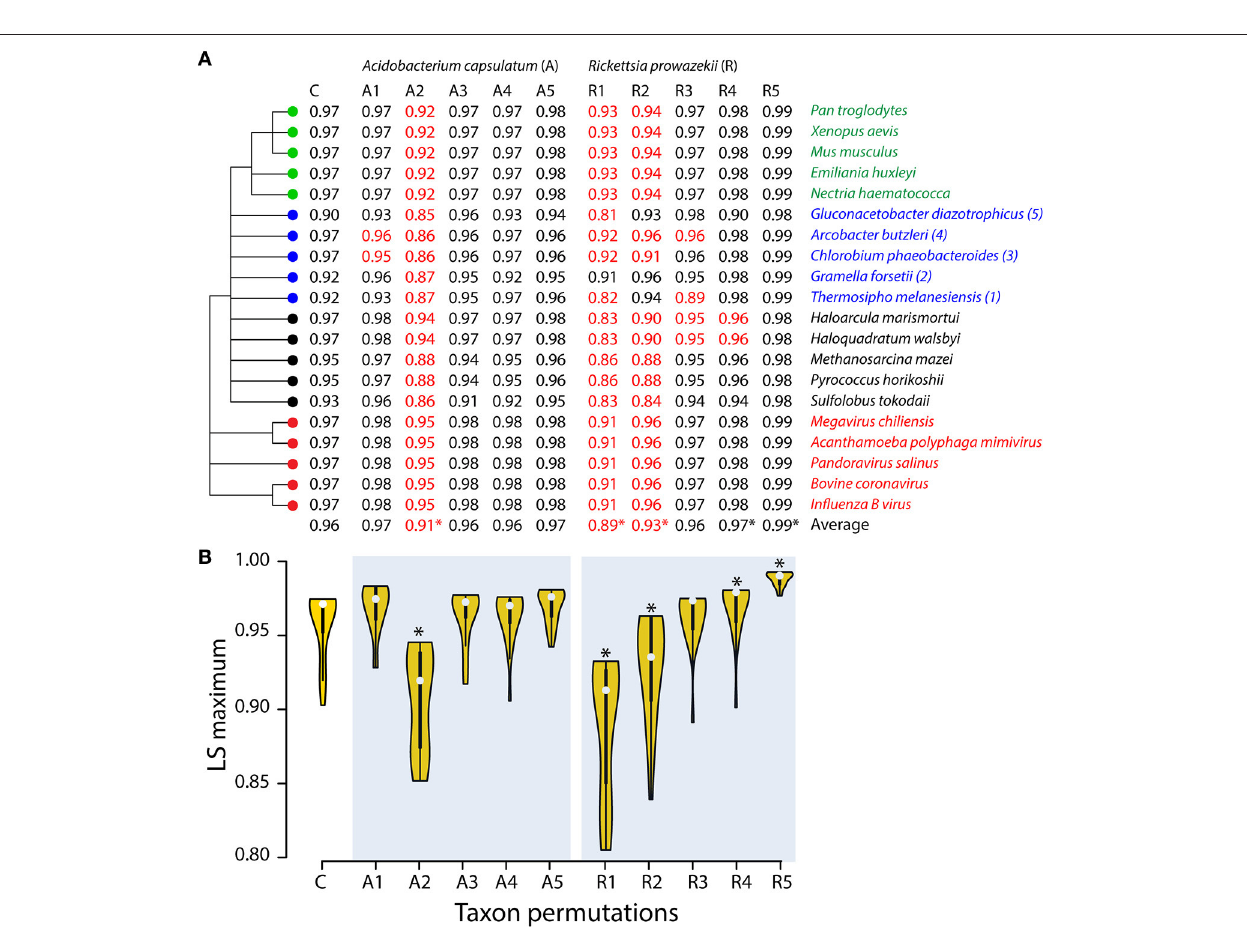
FIGURE 7 | Obligate parasitic taxa destabilize leaves of trees. (A) Leaf stabilities (LS maximum) were calculated with RadCon (Thorley and Page, 2000) from 2,000 unrooted BS trees. LS values are ordered in the table (A) according to the most informative strict reduced consensus (SRC) tree (33.54 bits) out of a set of 5 SRC trees, which matches the strict component consensus (consensus efficiency = 0.555) derived from the unrooted trees. (B) LS values are visualized as violin plots. Violin plot is a combination of the box plot (the black rectangle with white circle representing group median) and density plot on each side (yellow) reflecting data distribution. The spread of LS values was calculated for the control set (C) and all possible permutations of free-living Acidobacterium capsulatum (A1–A5) and the obligate endoparasite R. prowazekii (R1–R5) with individual taxa of the corresponding bacterial superkingdoms (identified with numbers following taxon labels). The density trace is plotted symmetrically around the boxplots. White circles are group medians. Asterisks are distributions significantly different from control C (Wilcoxon rank sum test, two-tailed, P < 0.01).